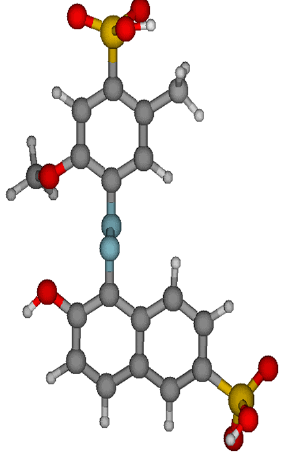
Figure 10. Ball and stick atomic model of Allura Red.